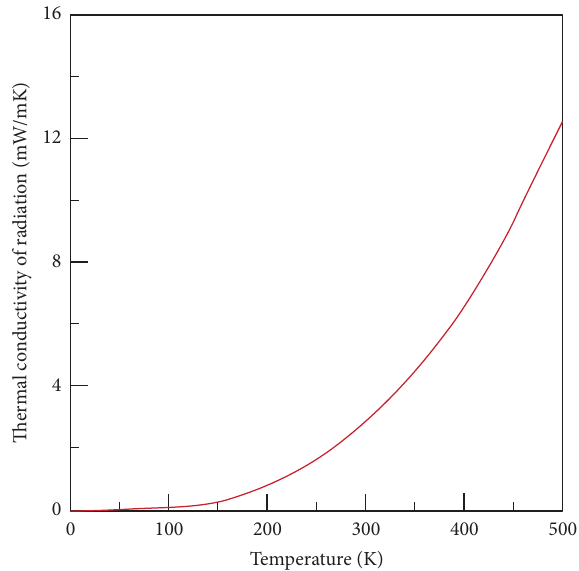
Figure 9: Relationship between the radiation thermal conductivity and temperature for gas-phase